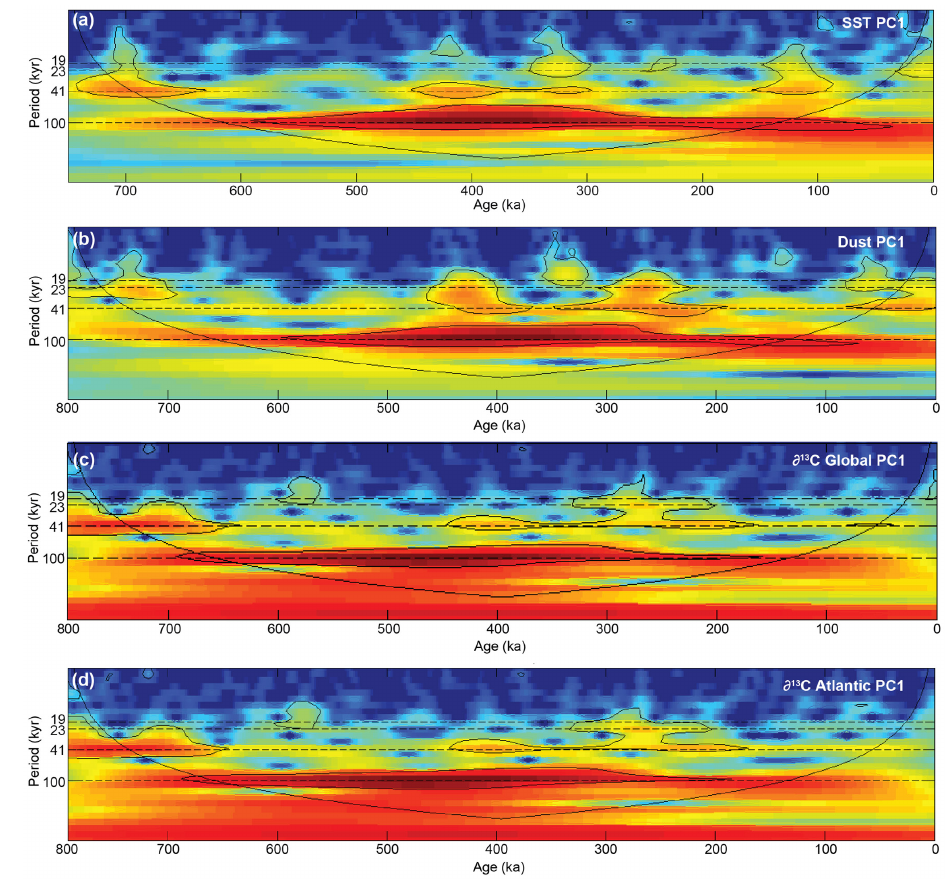
Figure 4. Wavelet analysis. Wavelets of four of the first principal components. (a) Sea-surface temperatures. (b) Dust records. (c) Global ∂ 13 C. (d) ∂ 13 C of the Atlantic. Red colors represent higher spectral power. Blue colors represent lower spectral power. Statistical significance is highlighted by the thin black line. Milankovitch periods are highlighted by the dashed horizontal